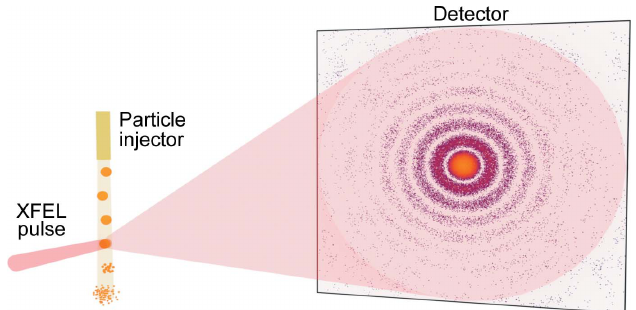
Figure 2 Experimental setup of an SPI-experiment to determine the spatial structure of a single biological particle. The specimen of the particle is injected into an X-ray laser beam in a random orientation, and the scattered radiation is recorded by the